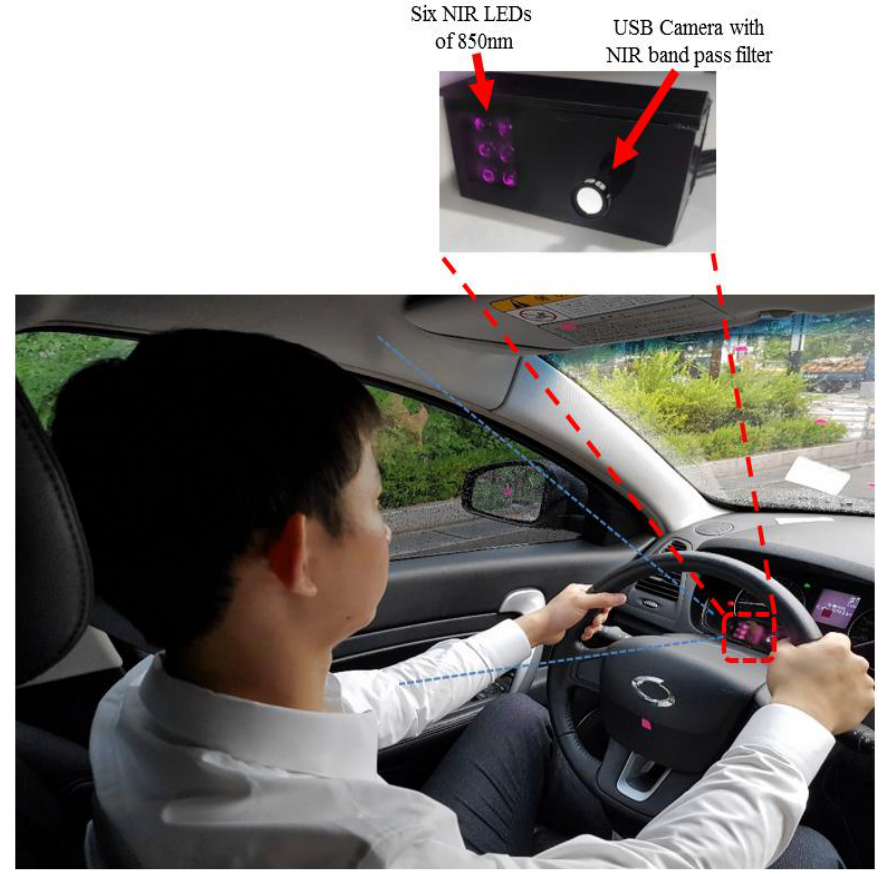
Figure 2. Experimental environment and proposed gaze detection system in vehicle environment.